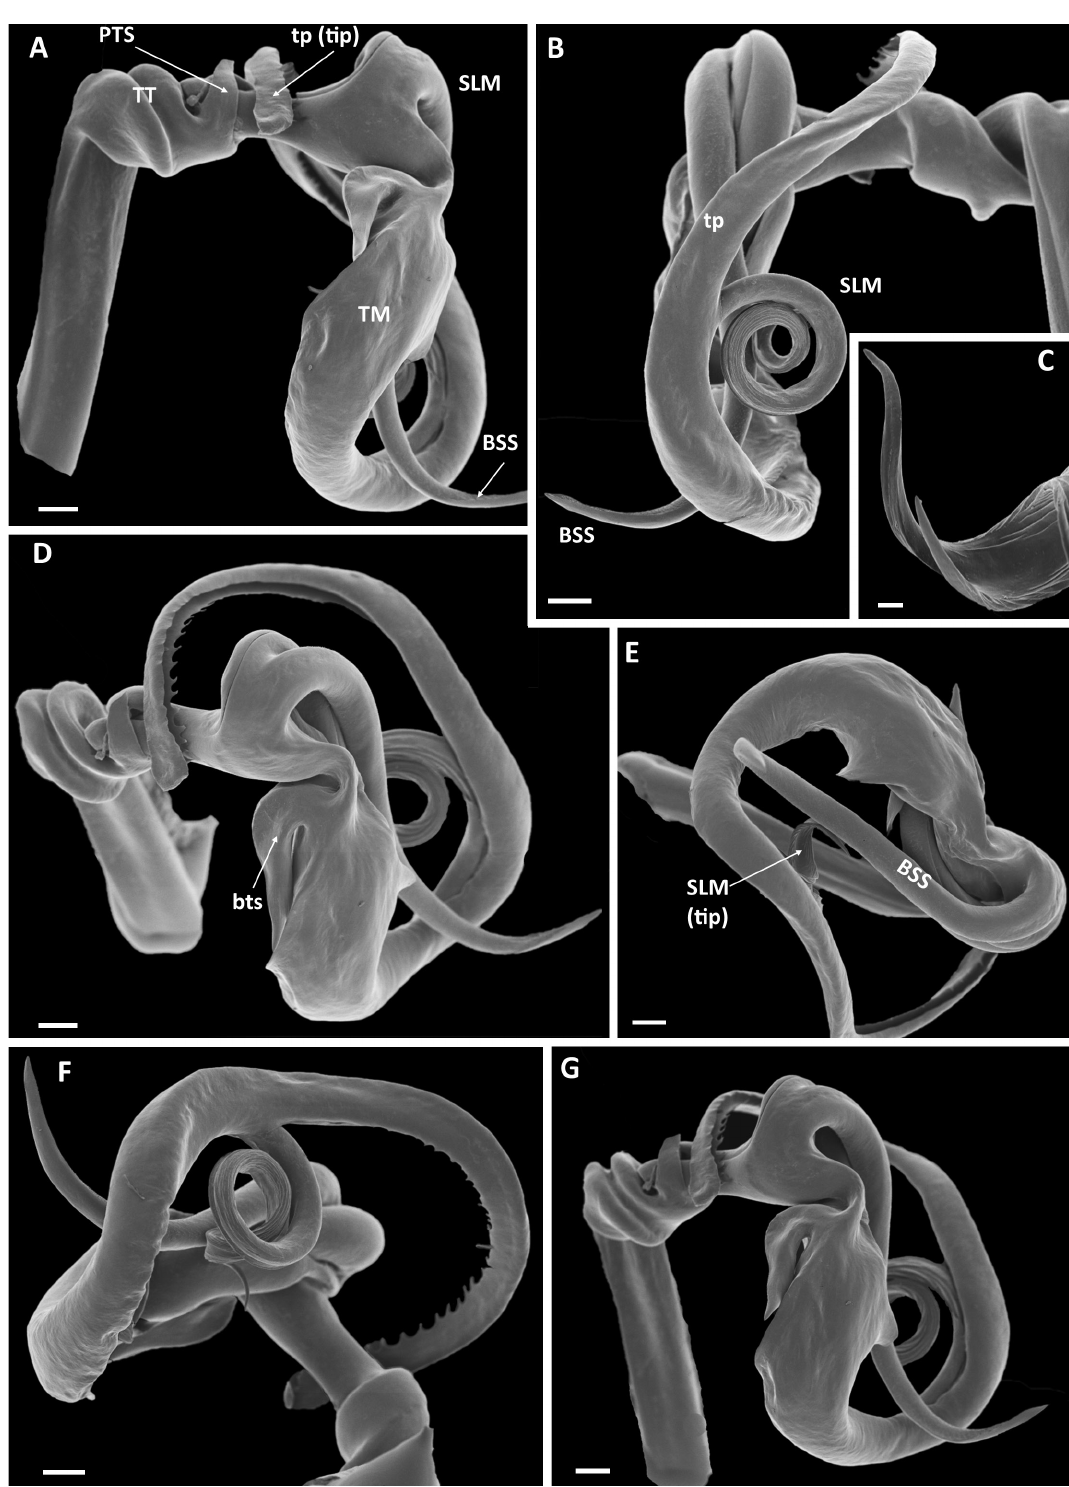
Fig. 45. Multipronopea agneteae gen. et sp. nov., holotype, ♂ (NHMD 621749), left gonopod telopodite. A . Anterior view, showing tip of telomere process. B . Posterior view. C . Tip of solenomere. D . Anterior- distal (ventral) view. E . Mesal view, showing tip of solenomere. F . Ventral view. G . Anterio-mesal view. Abbreviations: BSS = basal solenomeral spine; bts = besal telomeral spine; PTS = post-torsal spine; SLM = solenomere; TM = telomere; tp = telomeral process. Scale bars: A–B, D–G = 0.1 mm; C = 0.02